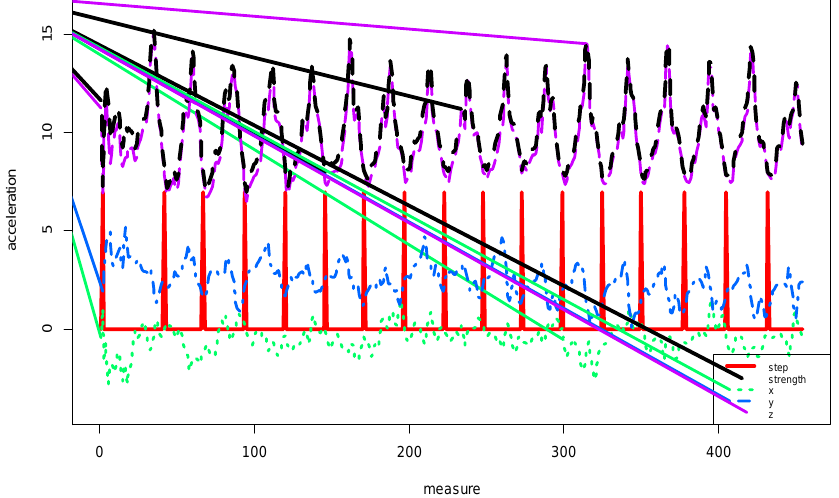
Figure 5. Variation of the accelerometers, force vector calculation and detection